Question: Give a one-sentence summary of this figure.
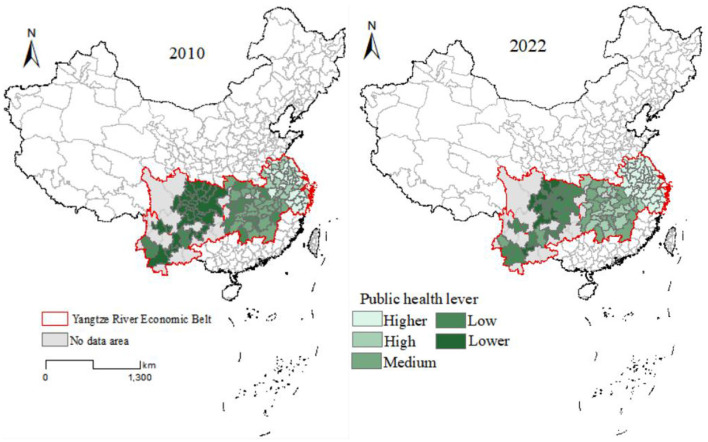
Answer: Spatial distribution of public health level.